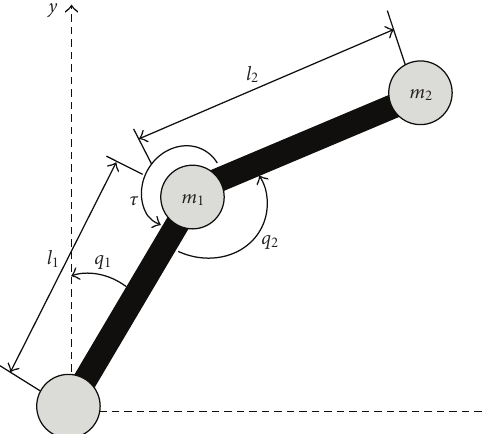
Figure 4: Phase portrait of the first joint trajectory and desired trajectory (+) for the unperturbed case (a) and perturbed case